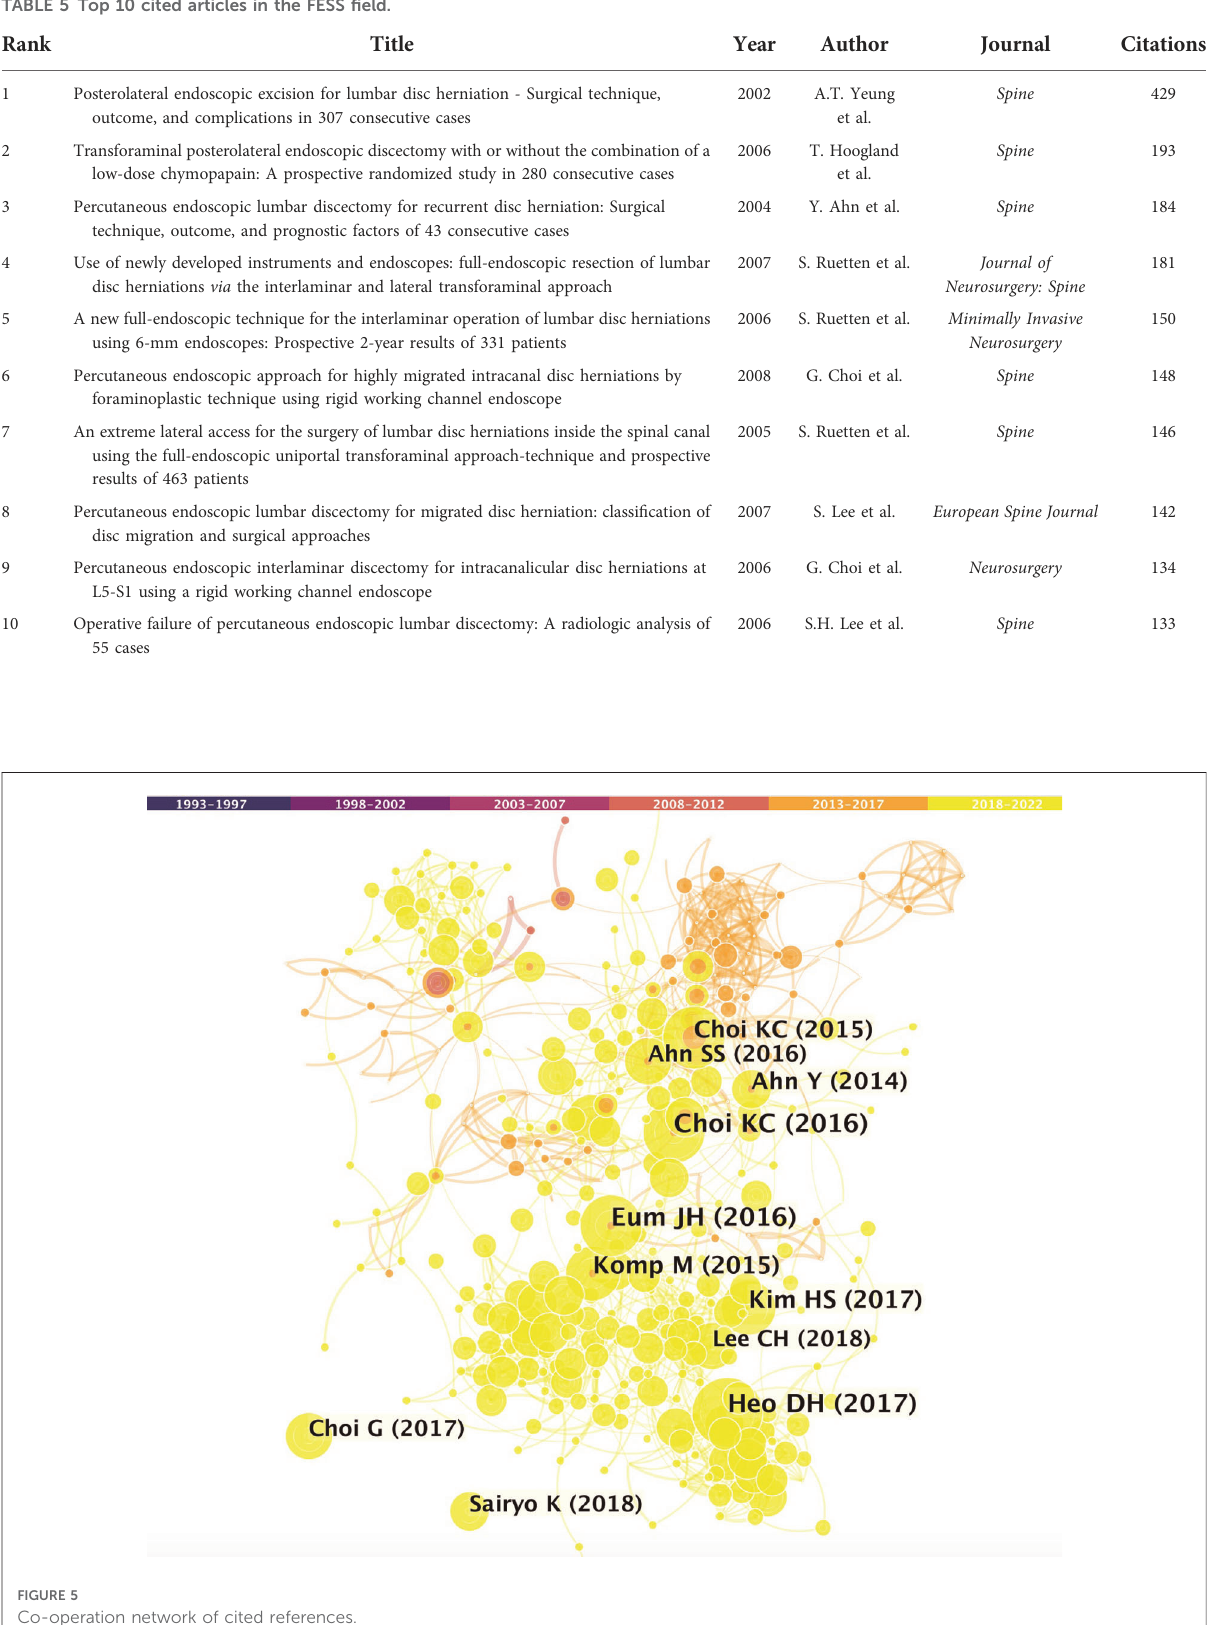
TABLE 5 Top 10 cited articles in the FESS fi eld.